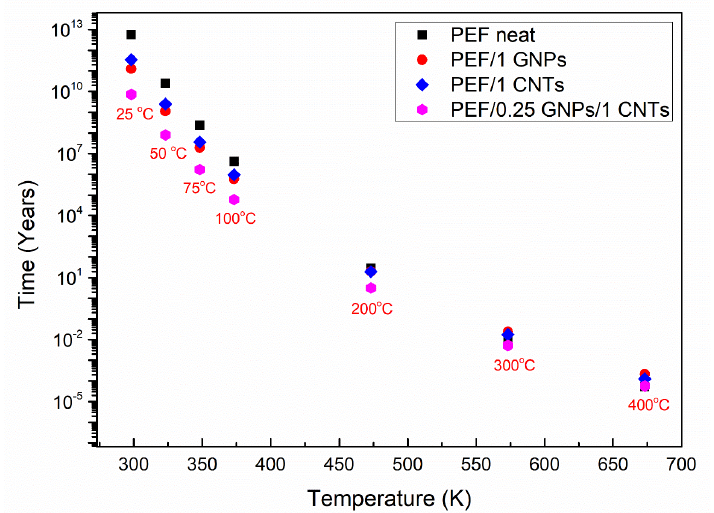
Figure 8. Lifetime predictions of neat PEF, PEF/1 GNPs, PEF/1 CNTs, and PEF/0.25 GNPs/1 CNTs nanocomposites for various selected temperatures under a dry air environment.